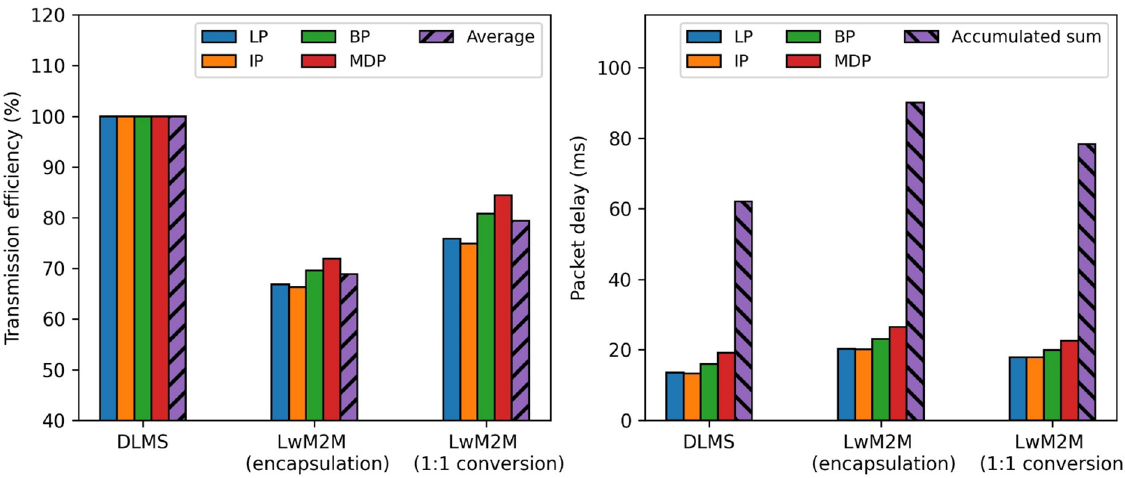
Figure 9. Comparison of the performance metrics (plaintext after session establishment).